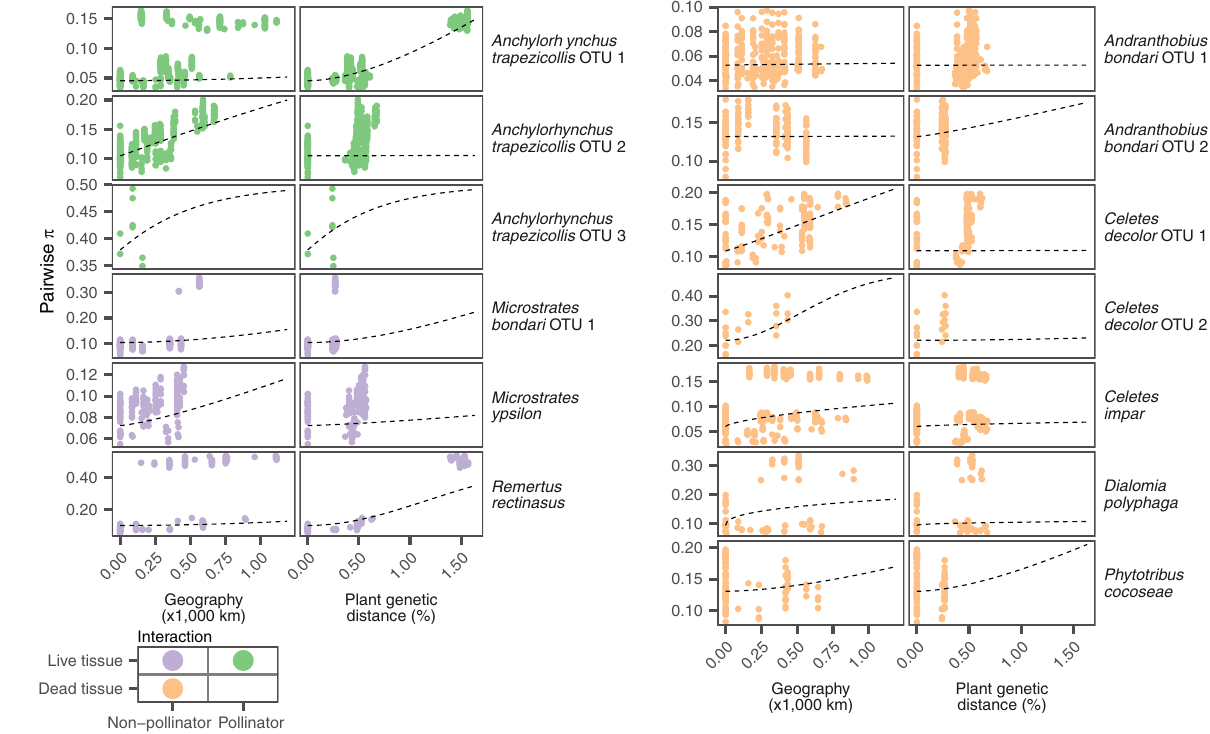
Fig. 2 Effects of geographical and plant distance on weevil pairwise genetic distance in variable sites (pairwise π ). Colors show whether a species breeds on live tissue and is a pollinator following the color key. Dashed lines show the marginal effects of each distance implied by average parameter estimates.